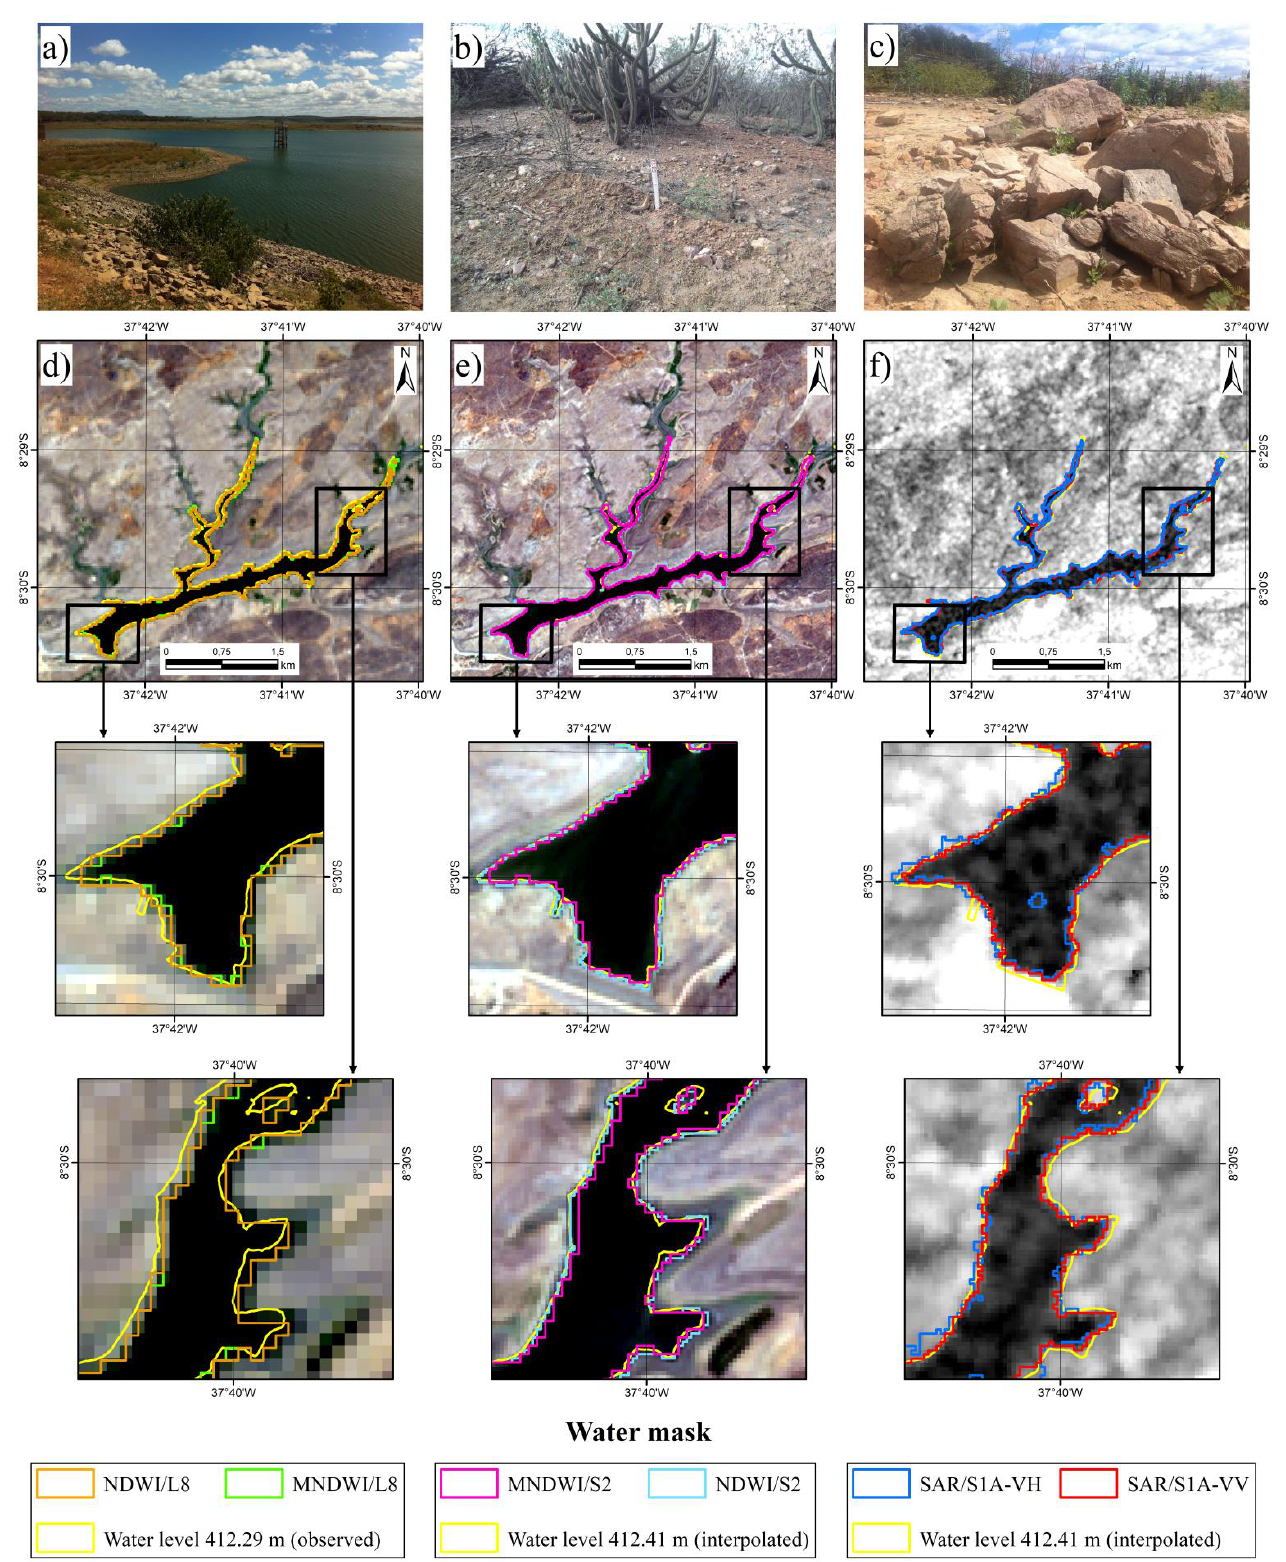
Figure 16. Water delimitation comparison with a low water level: ( a ) reservoir, ( b ) vegetation, ( c ) rock, ( d ) Landsat-8 (19 November 2017), ( e ) Sentinel-2 (12 November 2017), and ( f ) Sentinel-1A (12 November 2017).